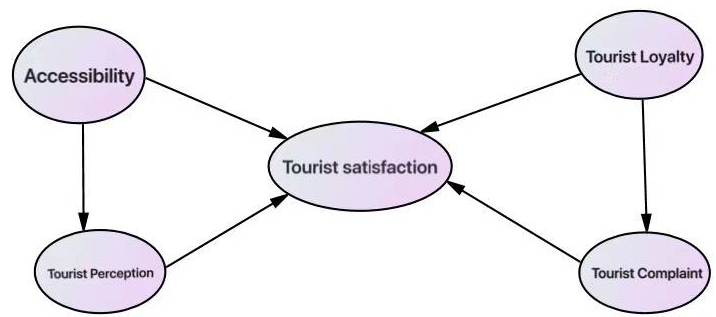
Figure 3. Map of Taihu Park.